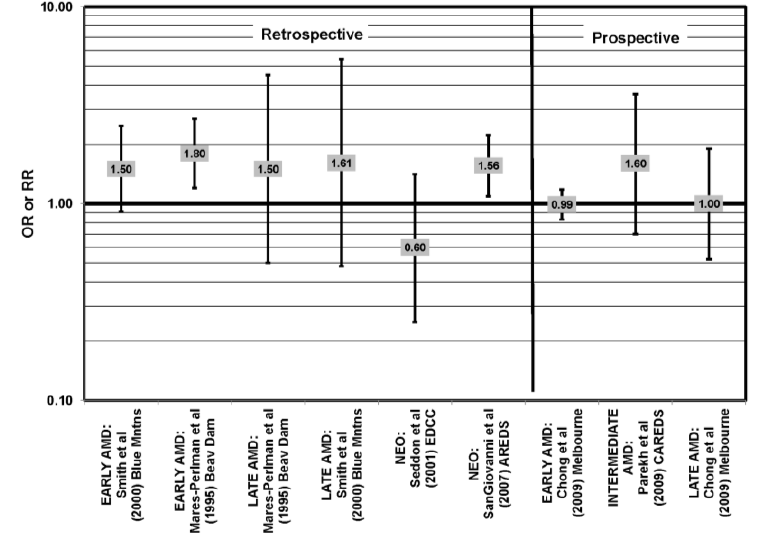
Figure 19. Odds or risk ratio for early AMD, intermediate AMD, late AMD or neovascular AMD (NEO); high vs. low intake of saturated fat: retrospective, cross-sectional and prospective studies.